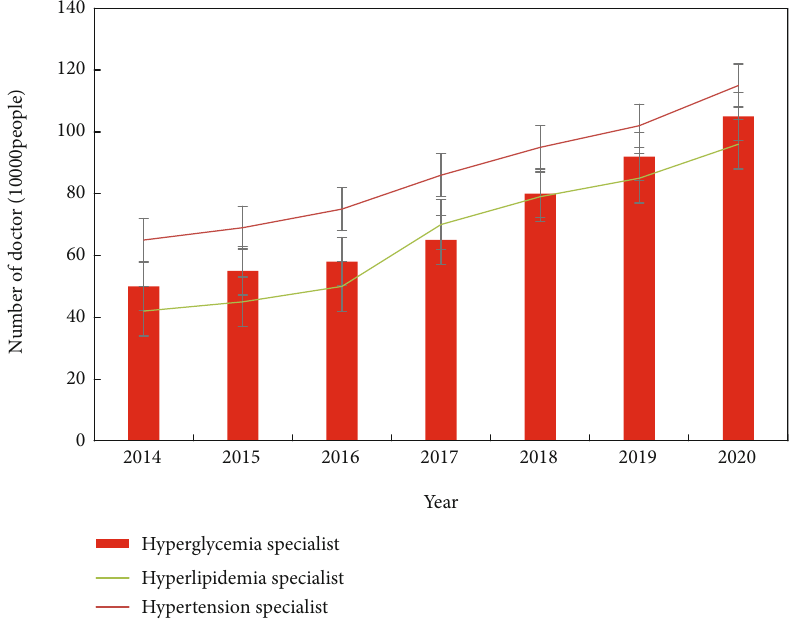
Figure 6: Number of chronic disease experts in my country in recent years. Table 3: Expert familiarity self-evaluation and results.